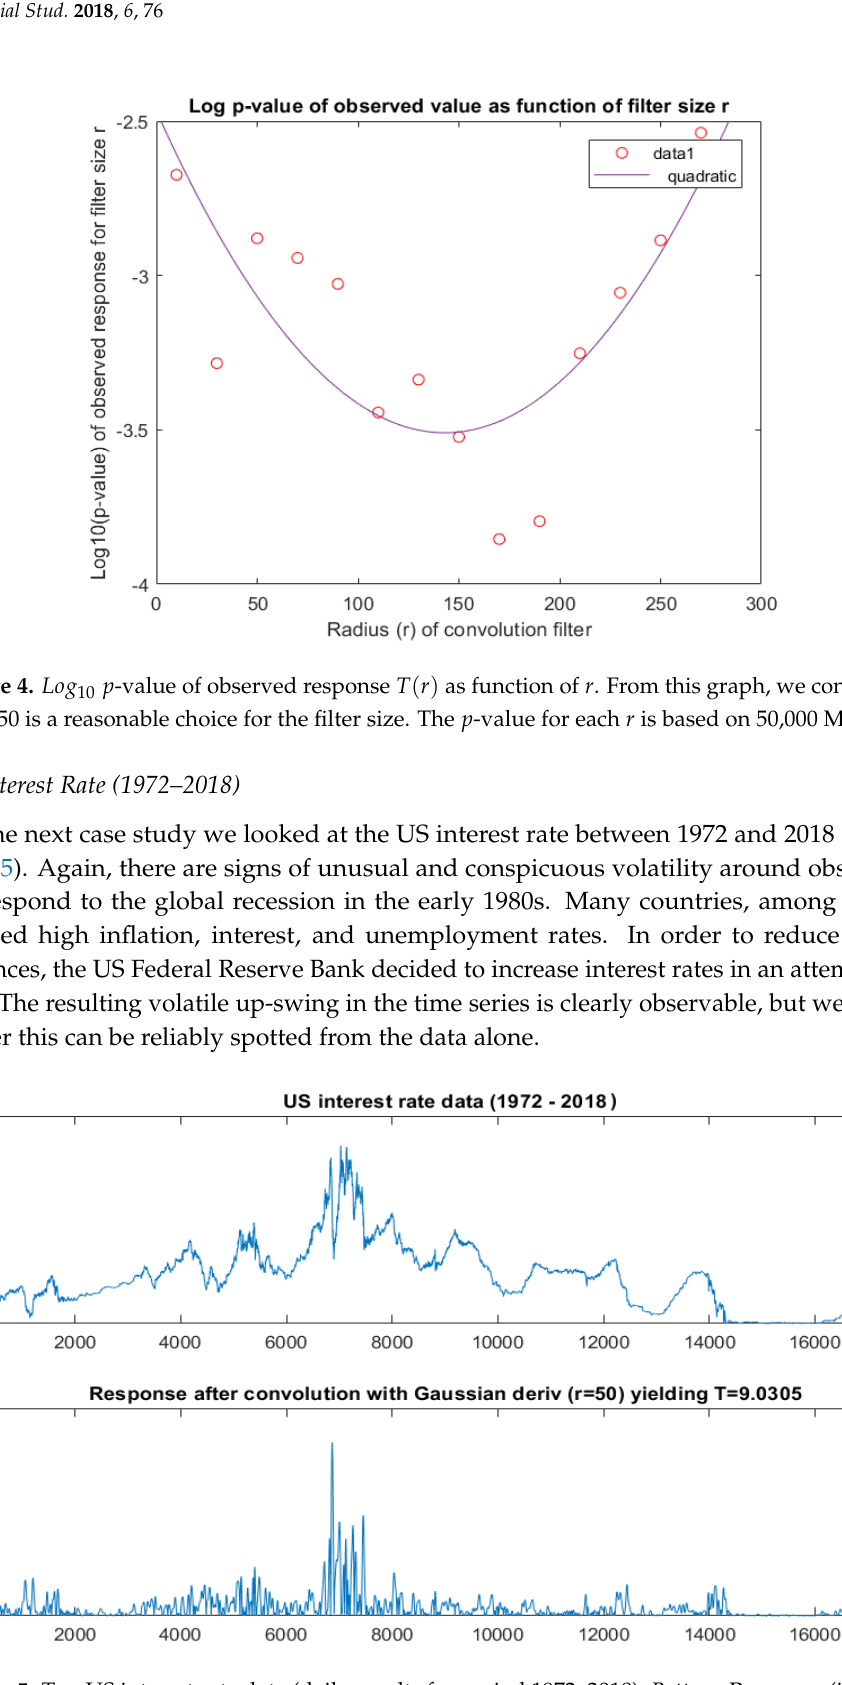
Figure 5. Top: US interest rate data (daily results for period 1972–2018); Bottom: Response (in absolute value) after convolution with a Gaussian derivative ( G (cid:48) r ) of size r = 50. The test statistic (the maximum value over the value of the 90% percentile, see Equation (5)) yields T obs =